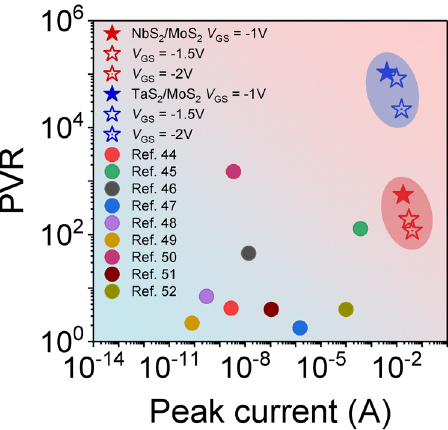
Fig. 7 Benchmark of PVR as a function of peak current. Other data are extracted from the BP/ReS 244 , MoS 2 /WSe 245 , Si/Ge 46 , BP/SnSe 247 , BP/Al 2 O 3 /BP 48 , Carbon quantum well 49 , WSe 2 /MoSe 250 , Gra/BN/ Gra 51 and Gra/WSe 2 /Gra 52 NDR devices. The blue and red oval marks represent the performance variation of NbS 2 and TaS 2 CM- FETs,